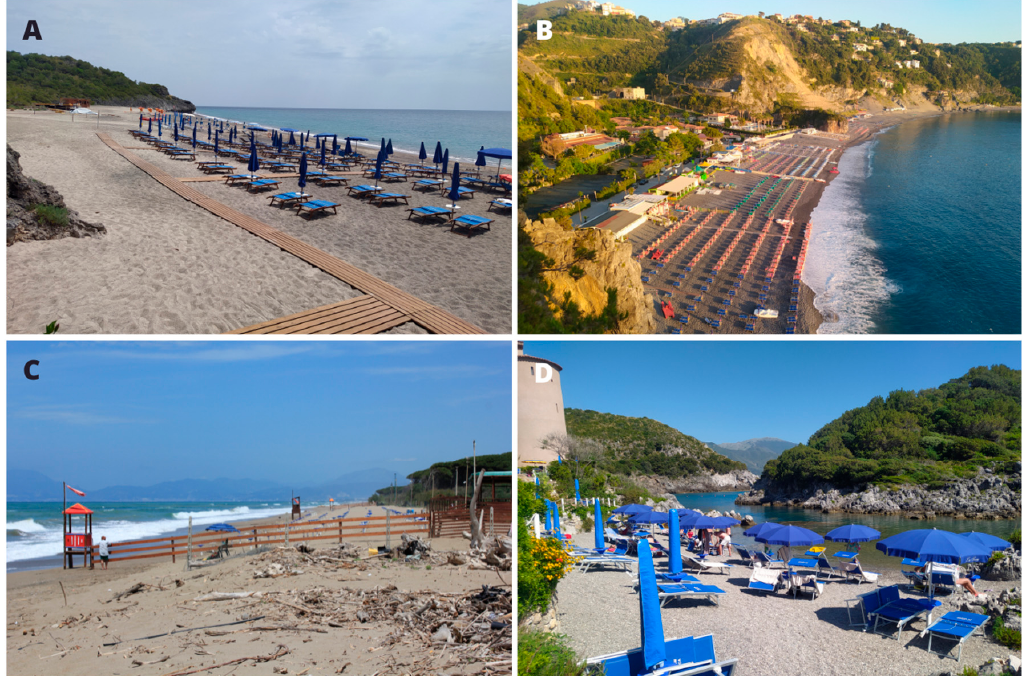
Figure 5. Scenic impact of beach facilities at Arconte (Gargano National Park) with >250 sunbeds along 200 m of beach length ( A ); typical beach case observed along the Tyrrhenian coast near Arco Magno in Cosenza ( B ); beach concession, which does not respect the free 5 m areas along the shoreline, within the Sele-Tanagro Natural Reserve at the border with the military restricted zone ( C ); pocket beach at Punta La Secca fully occupied by recreational facilities ( D ).